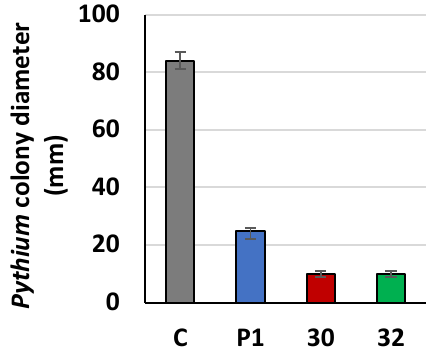
Figure 8. Growth inhibition of P. ultimum cultivated on plates pretreated with RER2 transformed T. atroviride. Trichoderma strains (30—RER30/11; 32—RER32/11) and control P1strain were cultivated for three days on MM plates covered with cellophane and then removed with the cellophane. P. ultimum was inoculated on the pretreated plates, and its rate of growth was determined as colony diameter after two days. As a control (C), P. ultimum was cultivated on non-pretreated plates. Data are presented as mean ± standard deviation from six independent experiments. Differences are statistically significant ( p < 0.05; t test).